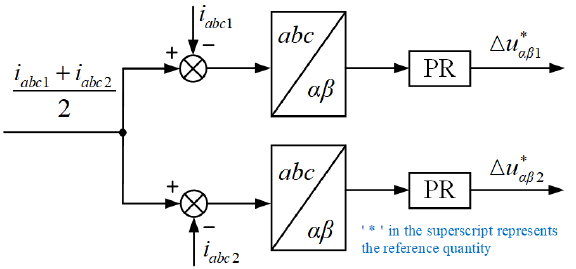
Figure 7. Schematic diagram of current-sharing loop control.